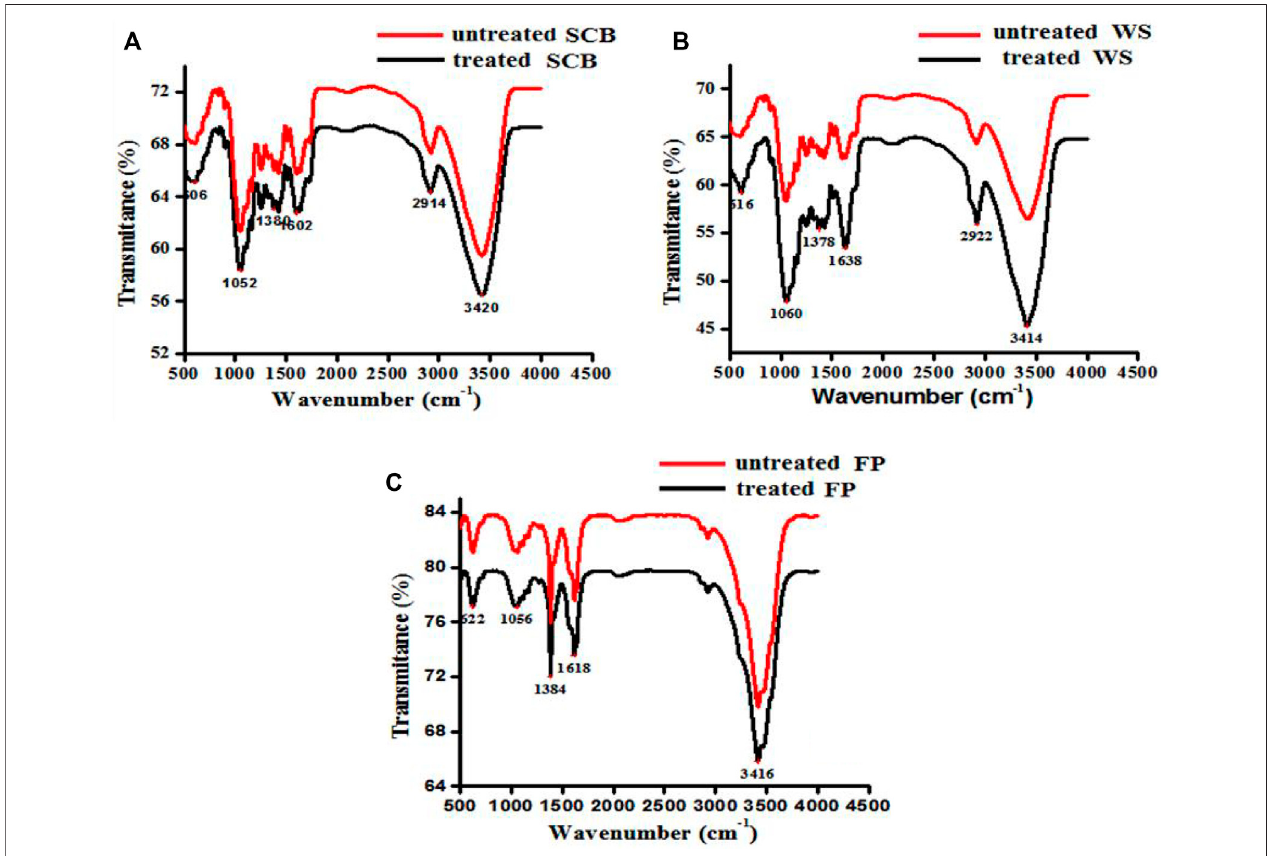
FIGURE 8 | FTIR spectra of untreated SCB, WS, and FP [ (A – C) denoted in red] and cellulase treated [ (A – C) denoted in black] biomass materials, respectively.